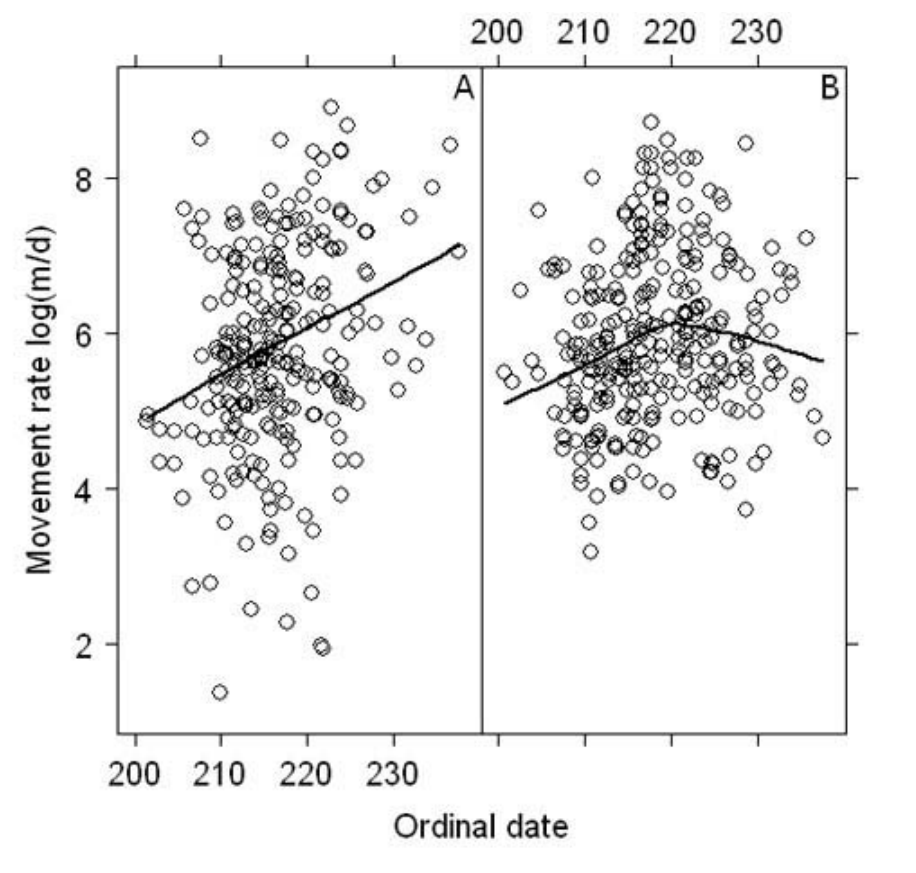
Fig. 8. Scatter-plot illustrating relationship between log(movement rate) and ordinal date for (A) Blackpoll and (B) Yellow-rumped Warblers. 200 = 20 July. Trends illustrated with locally weighted regression